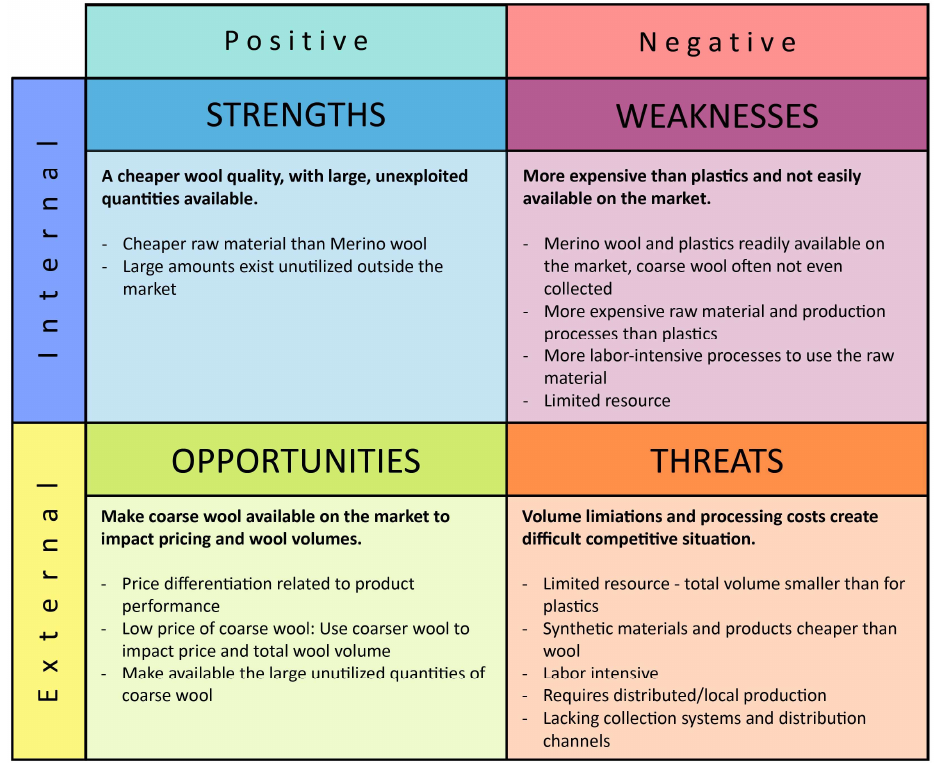
Figure 4. SWOT—Price and availability of coarse wool.